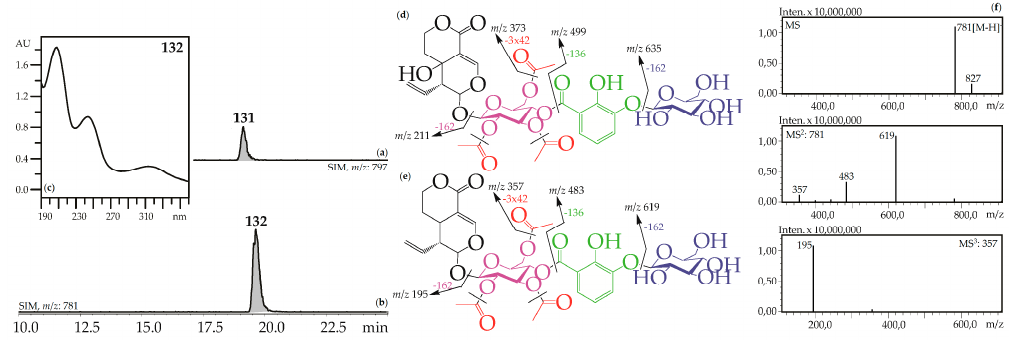
Figure 3. ( a,b ) HPLC-ESI-MS chromatogram of G. gelida root extract in SIM-mode: { m / z 797 for gelidoside (rindoside, 131 , a ); m / z 781 for trifloroside ( 132 , b )}. ( c ) UV spectrum of compounds 132 . ( d,e ) Mass spectrometric fragmentation of compounds 131 ( d ) and 132 ( e ). ( f ) MS n spectra of compound 132 .